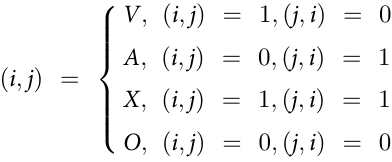
A contextual relationship was developed between each pair of elements using experts’ opin- ions based on the Delphi technique. Respondents filled the questionnaires by comparing the column statement of 105 questions to the row statement. The questions were about the direct link between barriers i and j . SSIM has been developed based on these relationships that emerged from the final results of Delphi round III, as shown in Table 6. Step 2: Compute the reachable matrix. • Initial Reachability Matrix (IRM) Formation After that, the initial reachability matrix (IRM) was developed by replacing V, A, X and O with 1s and 0s using Eq (8), as displayed in Table 7.